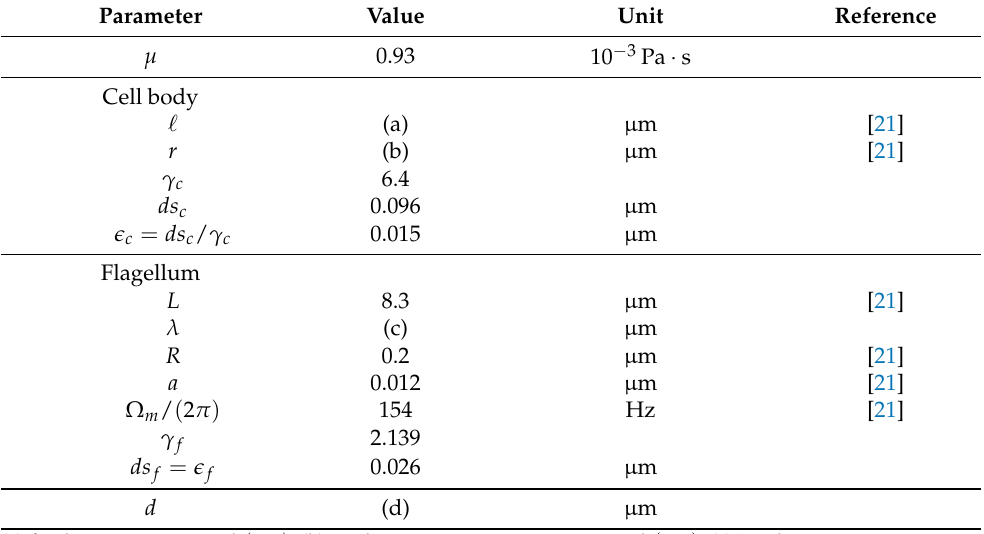
Table 2. Parameters values used in numerical